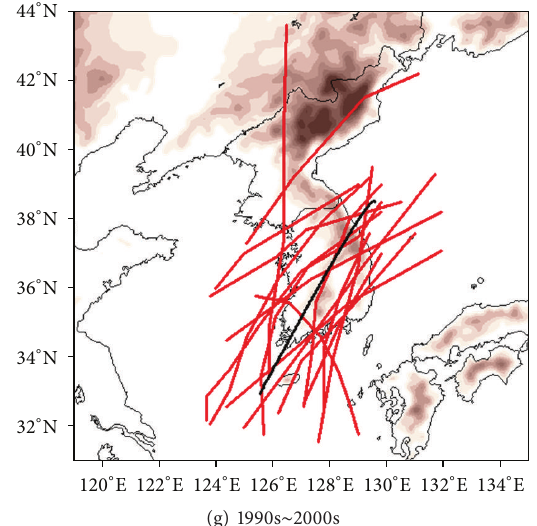
Figure 5: Decadal variation of the landfalling track of Korea-landfall TCs. Thick black lines denote regression mean tracks. Shaded areas indicate topography higher than 200